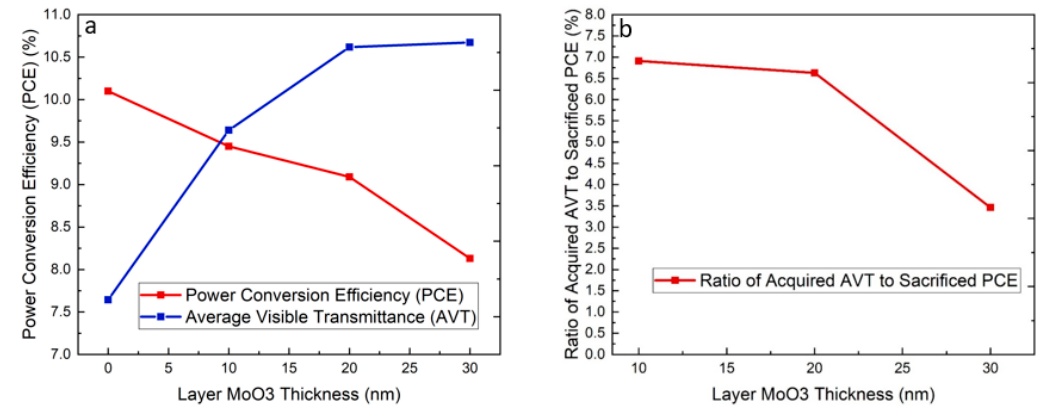
Figure 4. ( a ) The relationship between the power conversion efficiency (PCE) and average transmittance (AVT) versus the outer MoO 3 layer thickness; ( b ) the ratio of the acquired AVT to sacrificed PCE.